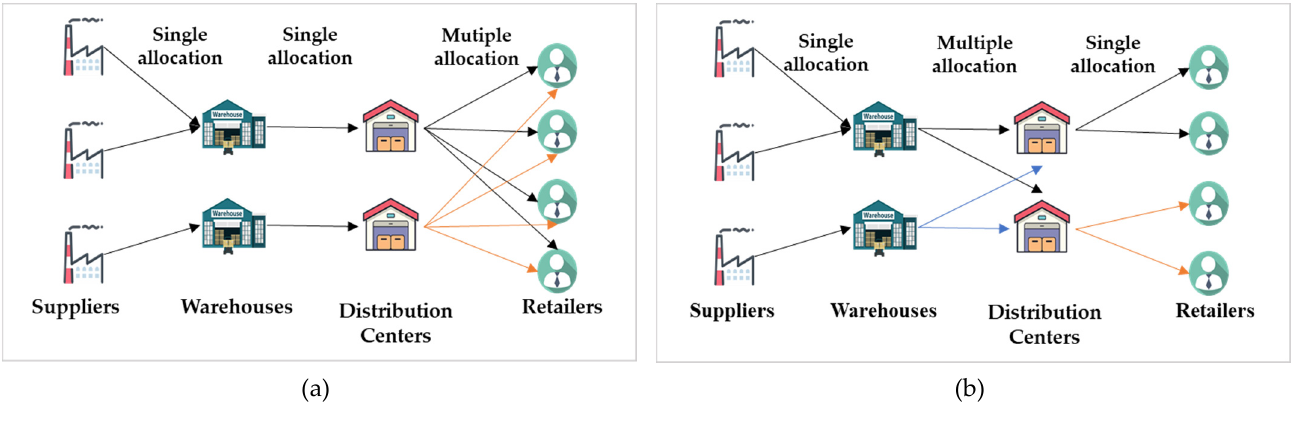
Figure 3. Examined scenarios. ( a ) Scenario Sc1; ( b ) Scenario Sc2.